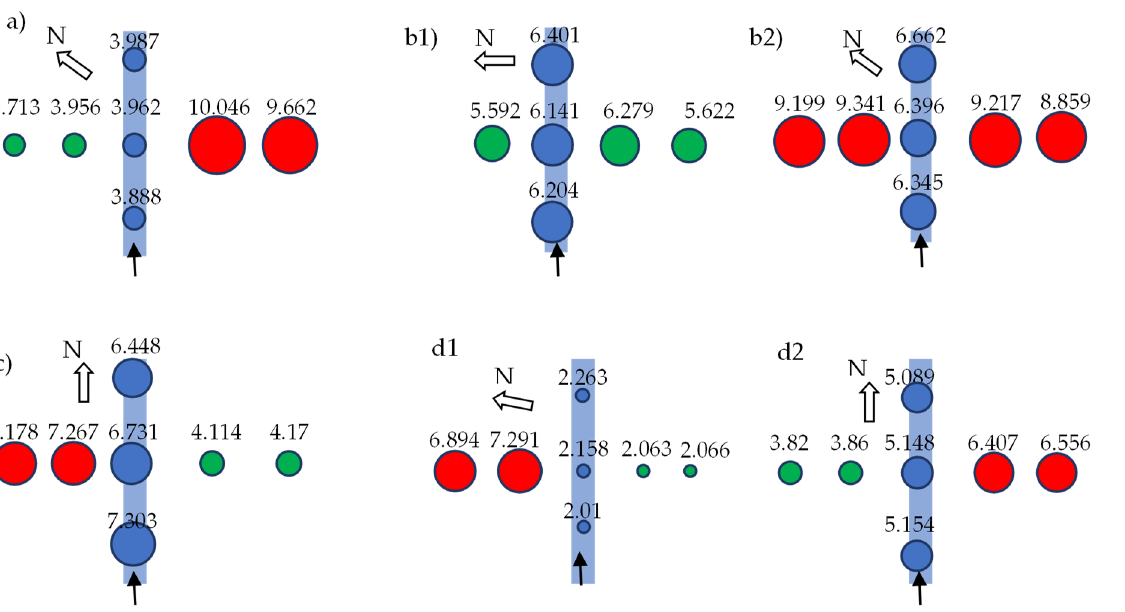
Figure 5. Concentrations of total nitrogen (N t ) in the groundwater of rivers and boreholes. Blue dots refer to the surface water samples, green dots refer to the ground water samples taken in organic farming areas and red dots refer to the ground water samples taken in intensive farming areas: ( a ) Alšia, ( b1 ) and ( b2 ) Žem ė pl ė ša, ( c ) Šuoja, ( d1 ) Romatas and ( d2 ) Lomena.